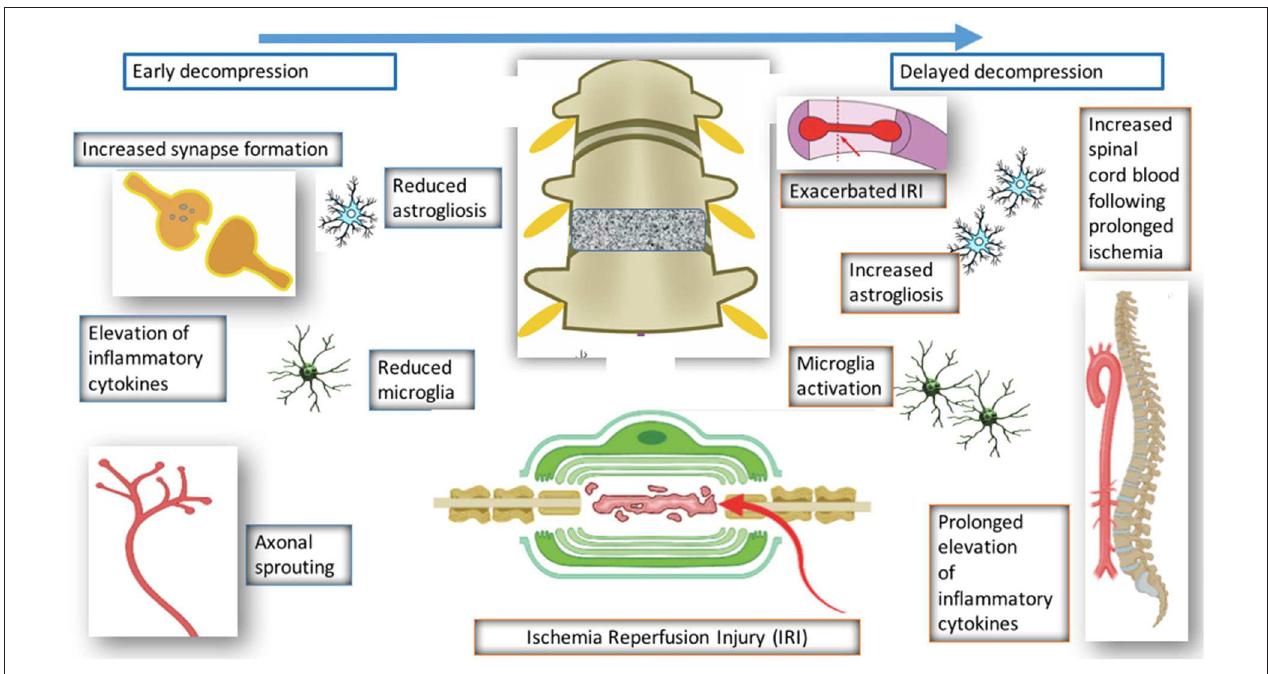
FIGURE 4 | Pathological changes following